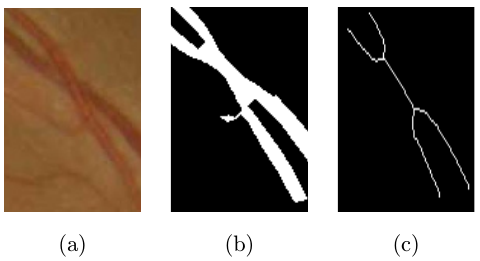
Fig. 9. Arteriovenous Crossing phenomenon. (a) Slice from original image showing Arteriovenous crossing, (b) Corre- sponding binary vessel segment and (c) Skeletonized vessel